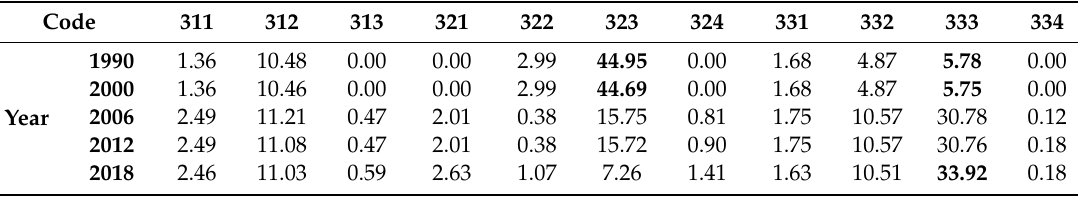
Table 5. Percentage of forest and semi-natural areas according to CORINE land cover nomenclature for level 3 in Canary Island in 1990, 2000, 2006, 2012 and 2018 (Source: authors). Code